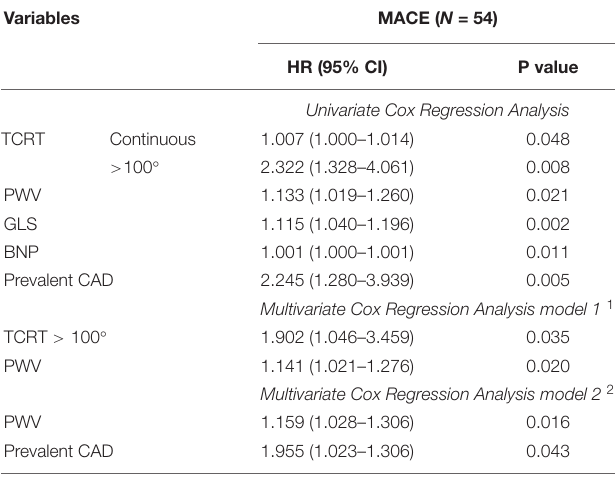
TABLE 5 | Variables associated with major cardiac events (MACE) by univariate and multivariate Cox regression